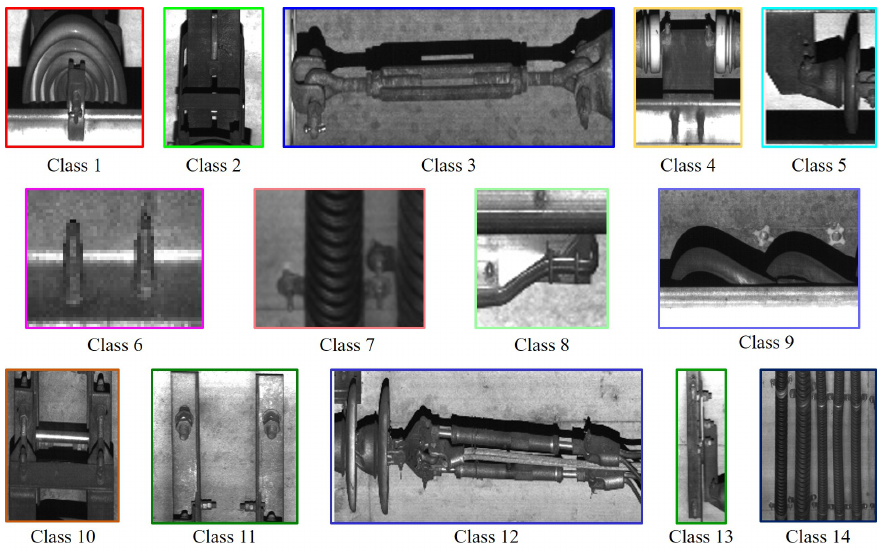
Figure 12. Classes forfacility detection used in the